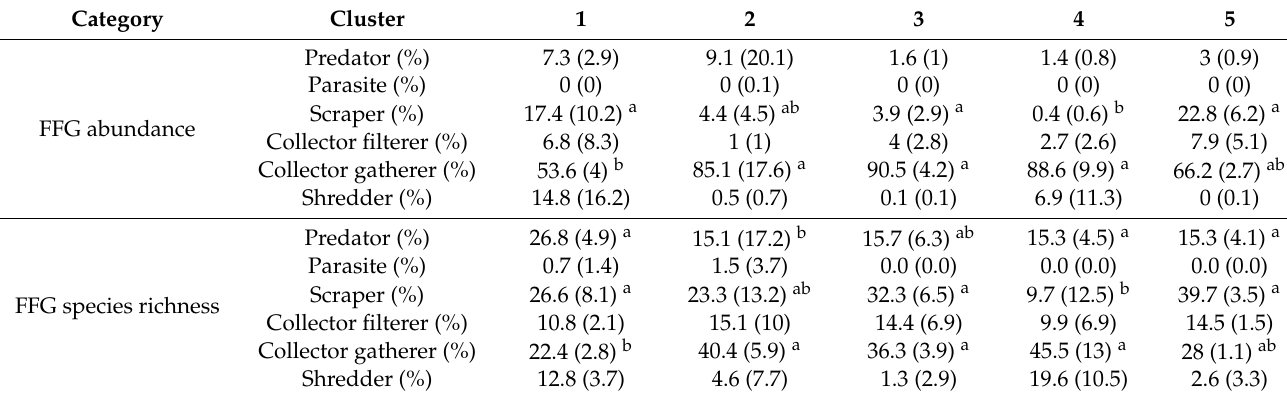
Values represent mean (standard deviation); Lowercase letters represent significant differences of environmental values among the five clusters based on the Kruskal-Wallis test and Dunn’s multiple comparison test ( p <